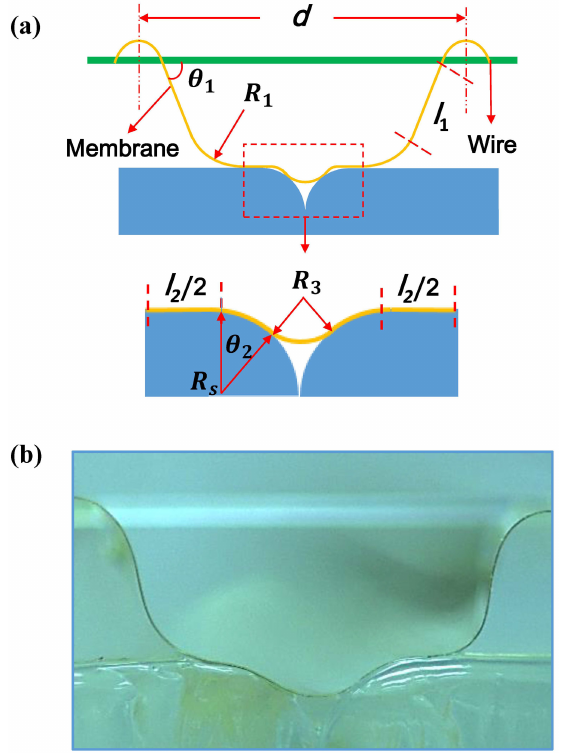
Figure 3. ( a ) Geometric model of the membrane in contact with a featureless flat surface in side view; ( b ) optical image of the membrane in its side